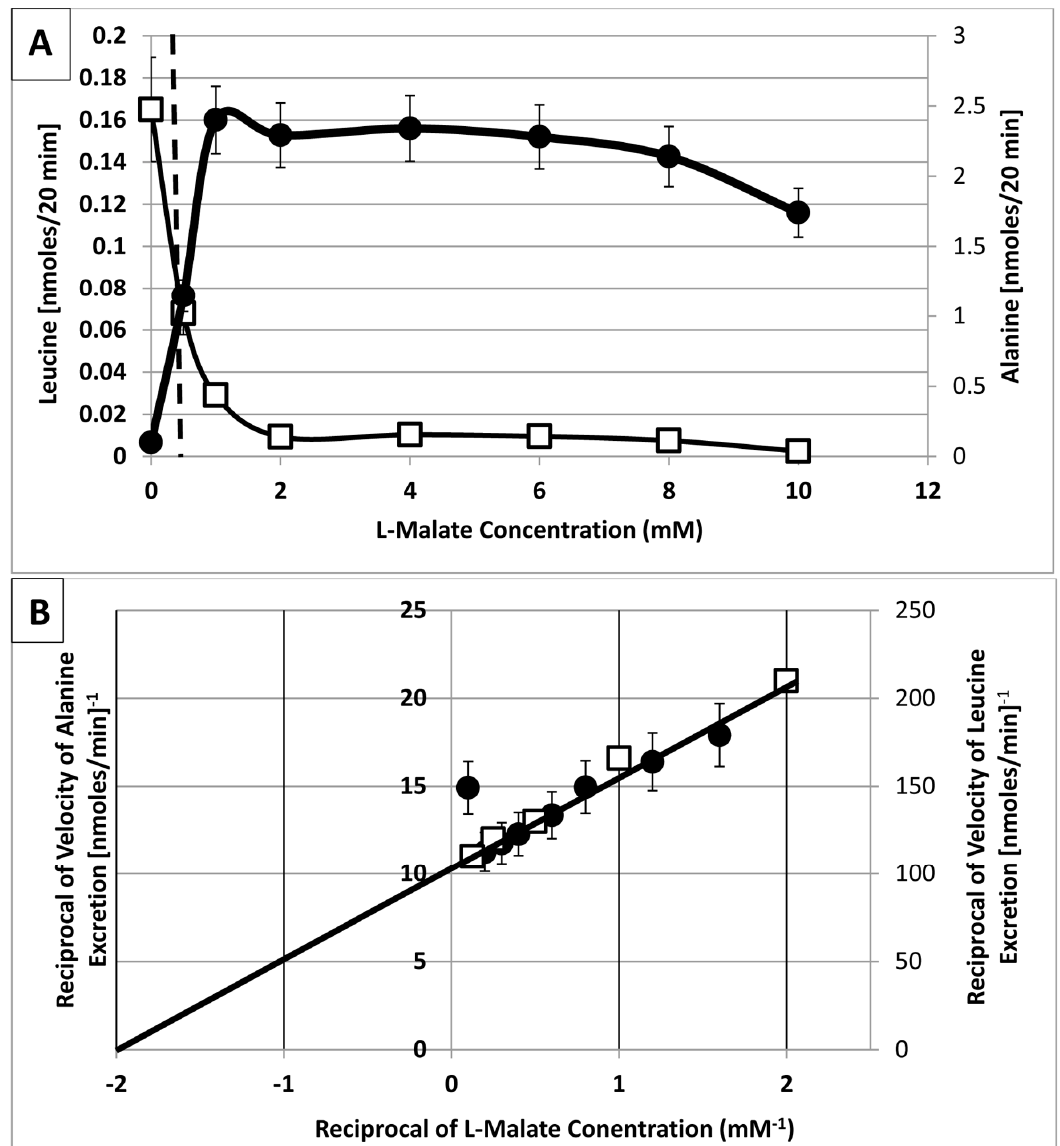
Figure 7. Alanine and leucine transport by ex planta B . diazoefficiens bacteroids. ( A ) Alanine and leucine transport from bacteroids as a function of malate concentration. The dashed line represents 0.5 mM L -malate. ( B ) Lineweaver-Burk plot of the reciprocal rate of alanine and leucine excretion versus the reciprocal of L -malate concentration. Absolute values of the leucine concentrations were used from ( A ) for inclusion in ( B ). Assays performed as described in Section 4 containing 18.4 mg dry weight of bacteroids and 0.008 atm partial pressure of oxygen. Each value is the mean of duplicates plus the range. The experiment shown is representative of two separate experiments. Alanine, closed circles; leucine, open squares.